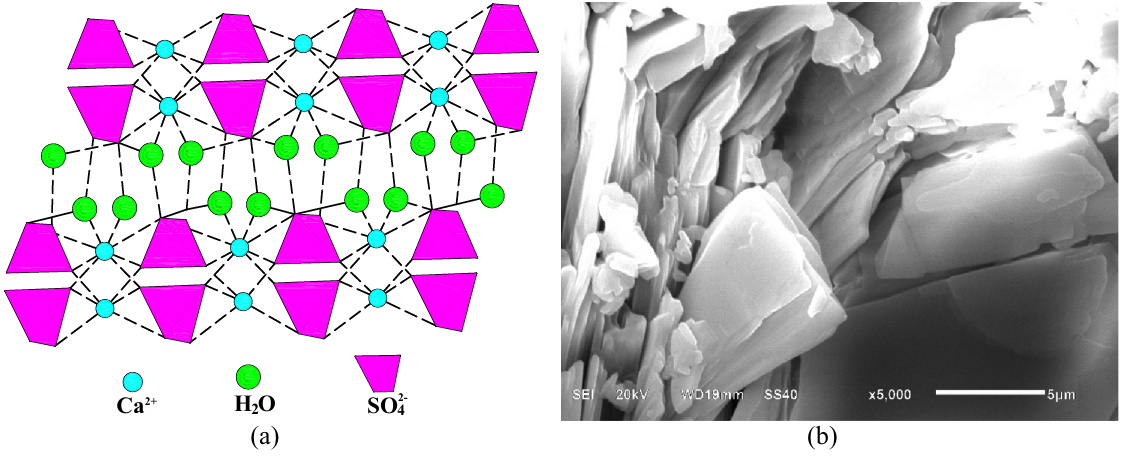
Figure 10. ( a ) Molecular space arrangement and ( b ) microstructure with layered structure at the magnification of 5000 of gypsum rock. (This figure (a) is a picture drawn by the Microsoft office 2016, https:// www. micro soft. com/ zh- cn/ micro soft- 365/ previ ous- versi ons/ micro soft- office- 2016, the figure(b)is not generated by other software but obtained by the SEM